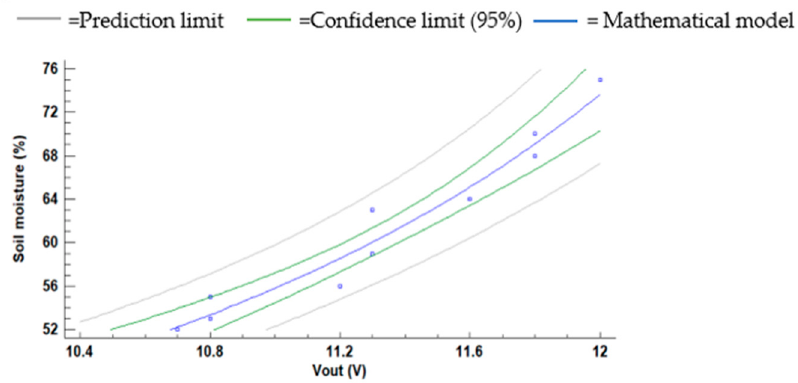
Figure 18. Vout of P9 using S1 and its mathematical model.